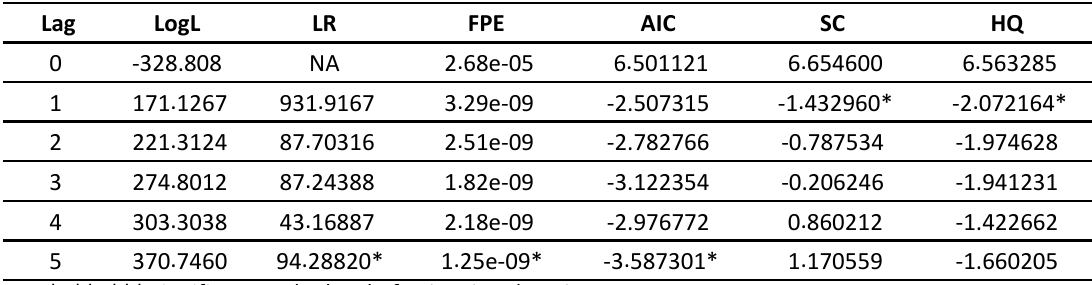
Table 3: Optimal Length Lag Test Results